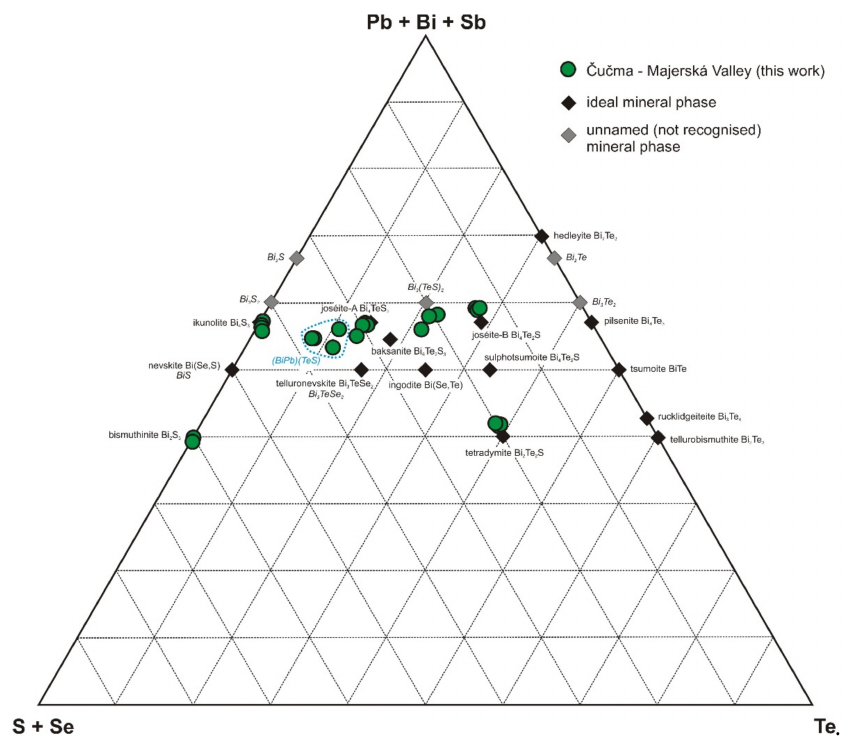
Figure 8. Chemical composition of the sulphotellurides, ikunolite and bismuthinite from ˇCuˇcma in ternary system S + Se-Te-Pb + Bi +